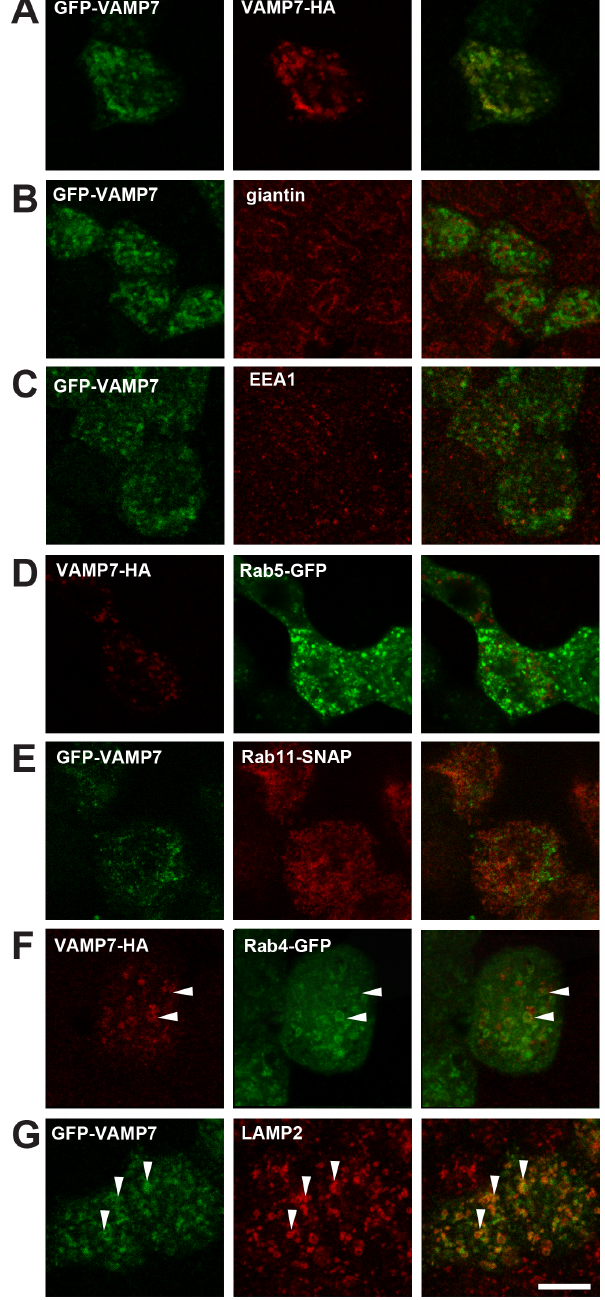
Figure 2. VAMP7 localization in polarized MDCK cells. Polarized MDCK cells grown on Transwells were transfected with GFP- or HA- tagged VAMP7 constructs and stained for the indicated endogenous proteins or co-transfected GFP- or SNAP-tagged organelle markers. (A) GFP-VAMP7 and VAMP7-HA colocalize with each other. Little colocaliza- tion is observed between VAMP7 and (B) giantin (Golgi), (C) EEA1 (early endosomes), (D) Rab5-GFP (early endosomes), or (E) Rab11a-SNAP. More extensive colocalization (marked by arrowheads) is observed between VAMP7 and (F) Rab4-GFP (recycling endosomes) and (G) LAMP2 (late endosomes and